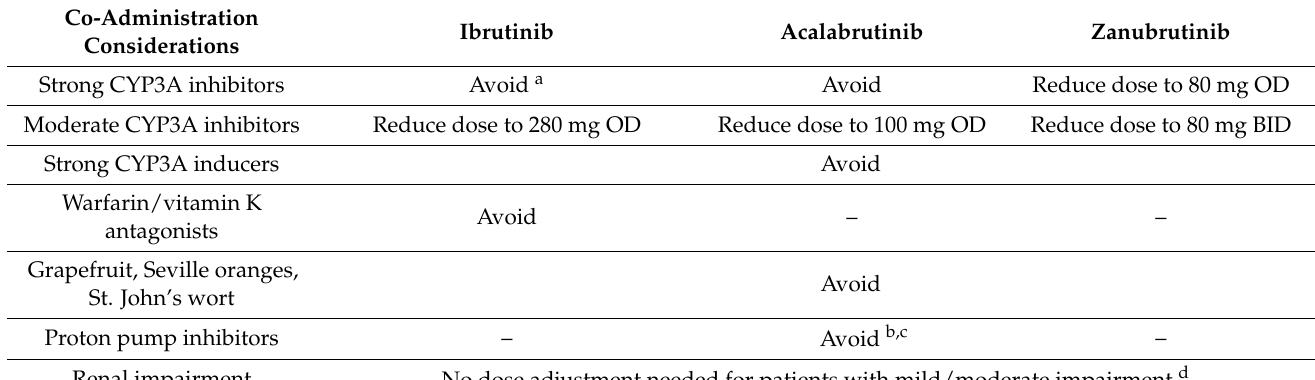
Table 3. Co-administration considerations for ibrutinib, acalabrutinib, and